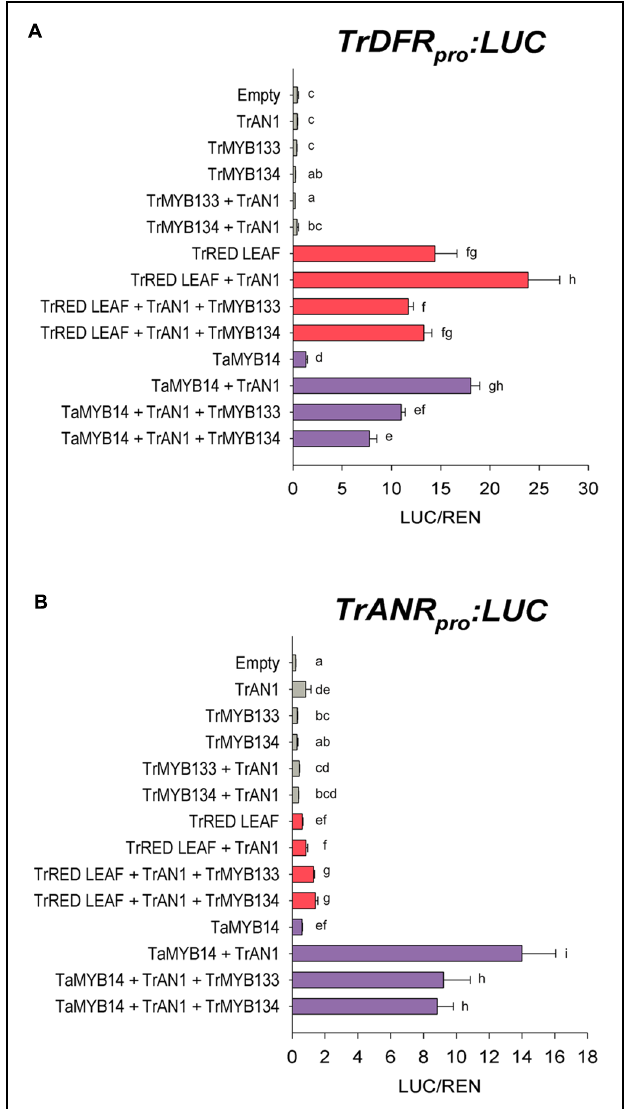
FIGURE 2 | Tr-MYB133 and Tr-MYB134 repress flavonoid biosynthetic genes. Promoter activation/repression dual luciferase assays upon (A) the Tr-DFR (anthocyanin and proanthocyanidin biosynthetic gene) promoter or (B) the Tr-ANR promoter (proanthocyanin biosynthetic gene), using Agrobacterium -infiltrated Nicotiana benthamiana leaves. Combinations of activator R2R3-MYB genes Tr-RED LEAF (anthocyanin) or Ta-MYB14 (proanthocyanidin) were tested with or without the bHLH factor Tr-AN1, and the R2R3-MYB repressors Tr-MYB133 or Tr-MYB134. Firefly luciferase activity was normalized to Renilla luciferase activity (LUC/REN); mean ± SEM n = 5 biological replicates are shown. Mean that are significantly different are indicated by different letters, as determined by post hoc Fisher’s LSD